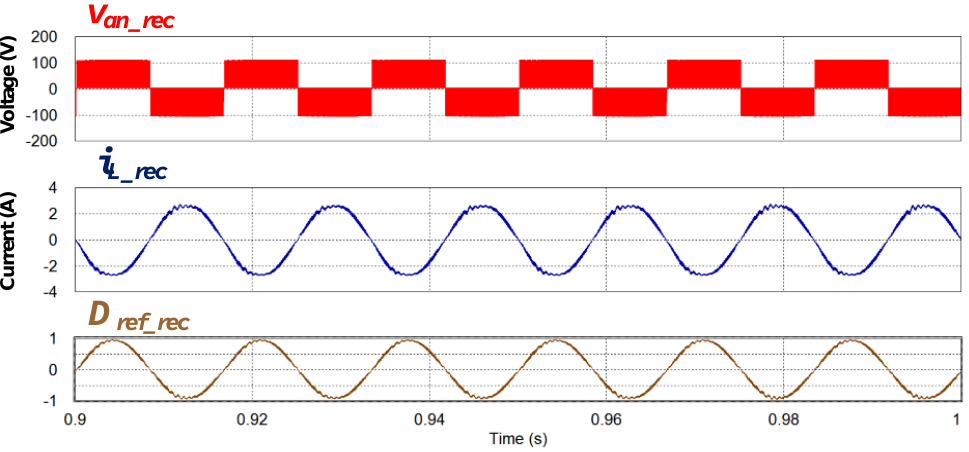
Figure 8. Simulation results of the rectifier.